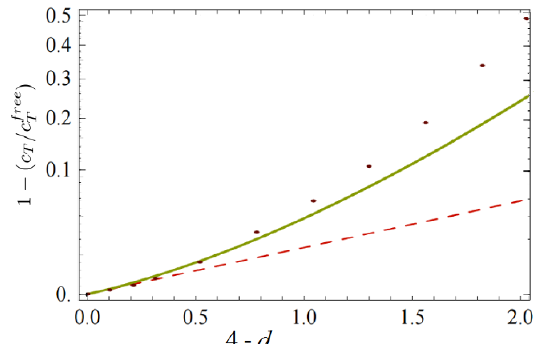
Figure 2 . Plot of c T against (cid:15) , showing its variation in 2 < d < 4. The dots indicate numerical c free bootstrap results [94]. The dashed red line indicates the analytic result with only the O ( (cid:15) 2 ) term. The smooth green line is the one including the O ( (cid:15) 3 ) and gives a more closer